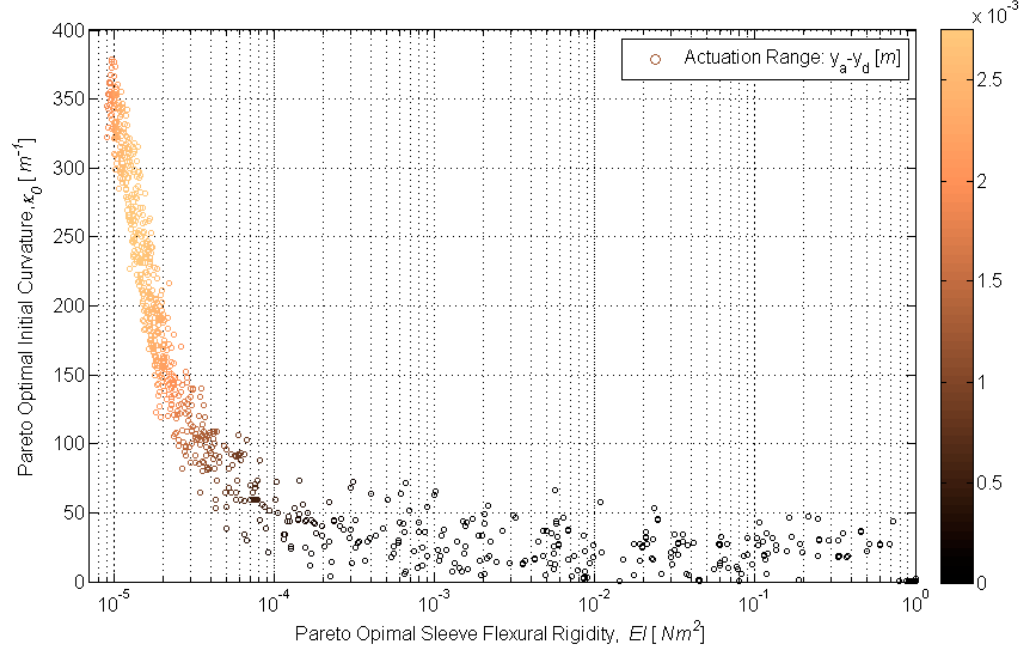
Figure 18. Interaction of Pareto-optimal design variables (initial curvature, κ 0 , and flexural rigidity, EI) as a function of actuation range ( y a − y d ) .